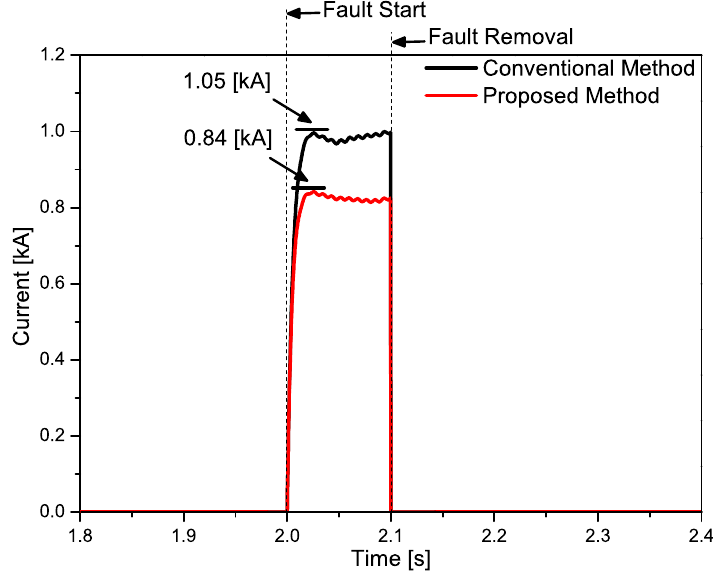
Figure 13. The current flowing in the